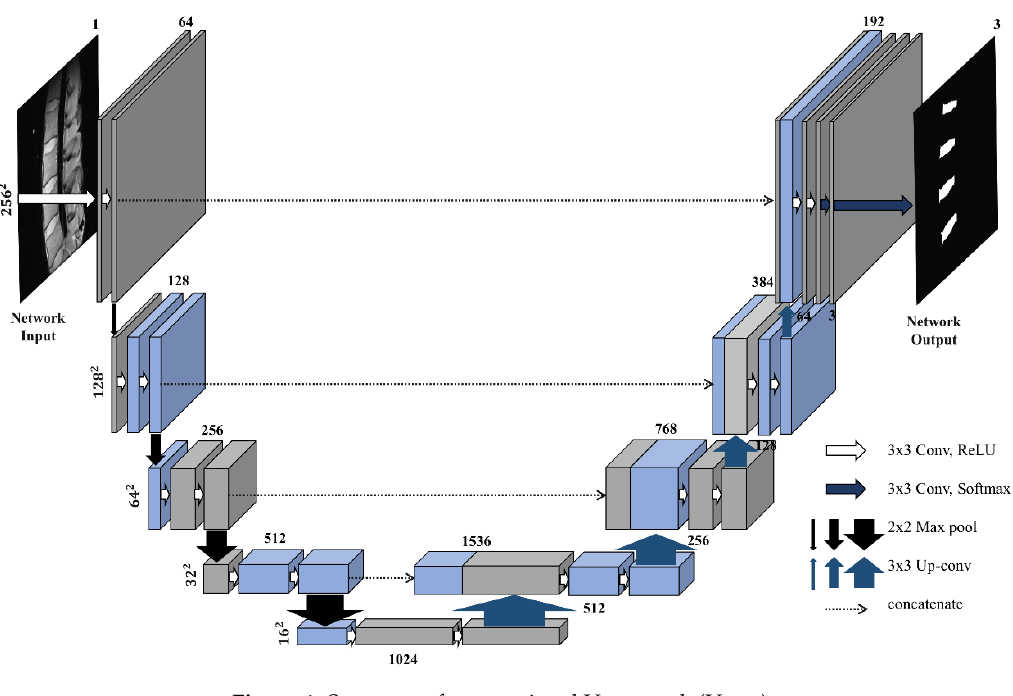
Figure 1. Structure of conventional U-network (U-net).